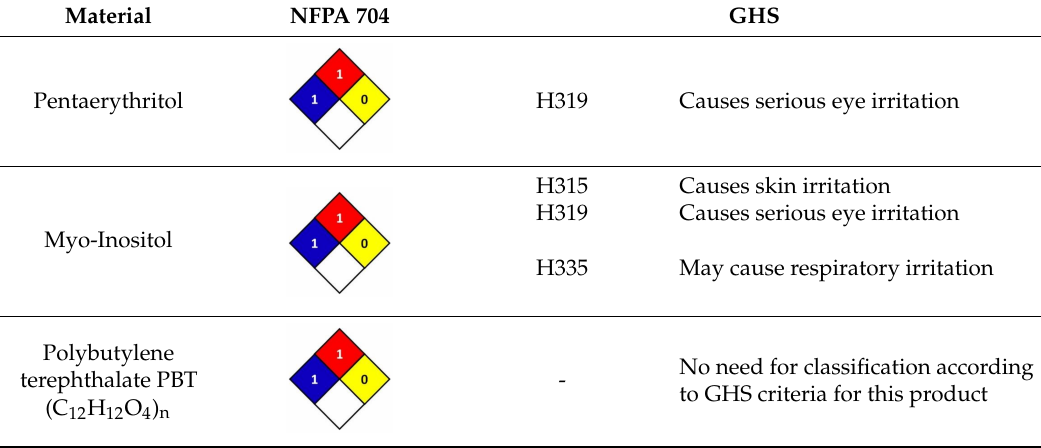
Table 6. Health hazard values according to NFPA 704 and GHS of the considered organic materials [31,32].